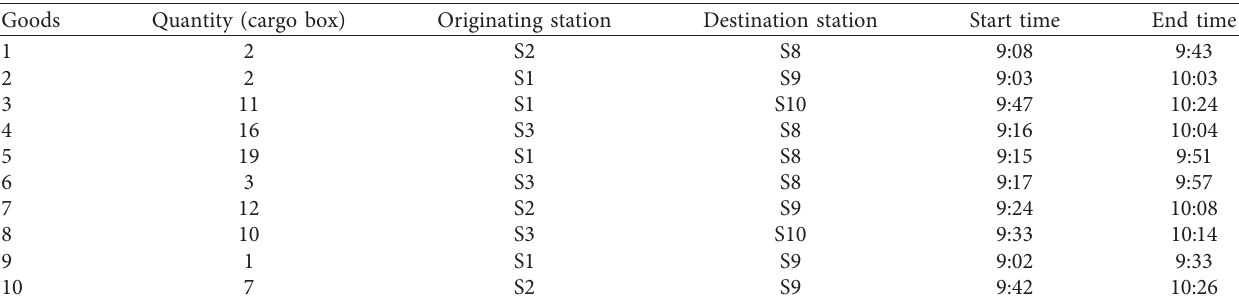
Figure 8: Schematic diagram of metro freight and freight Table 3: Freight information.